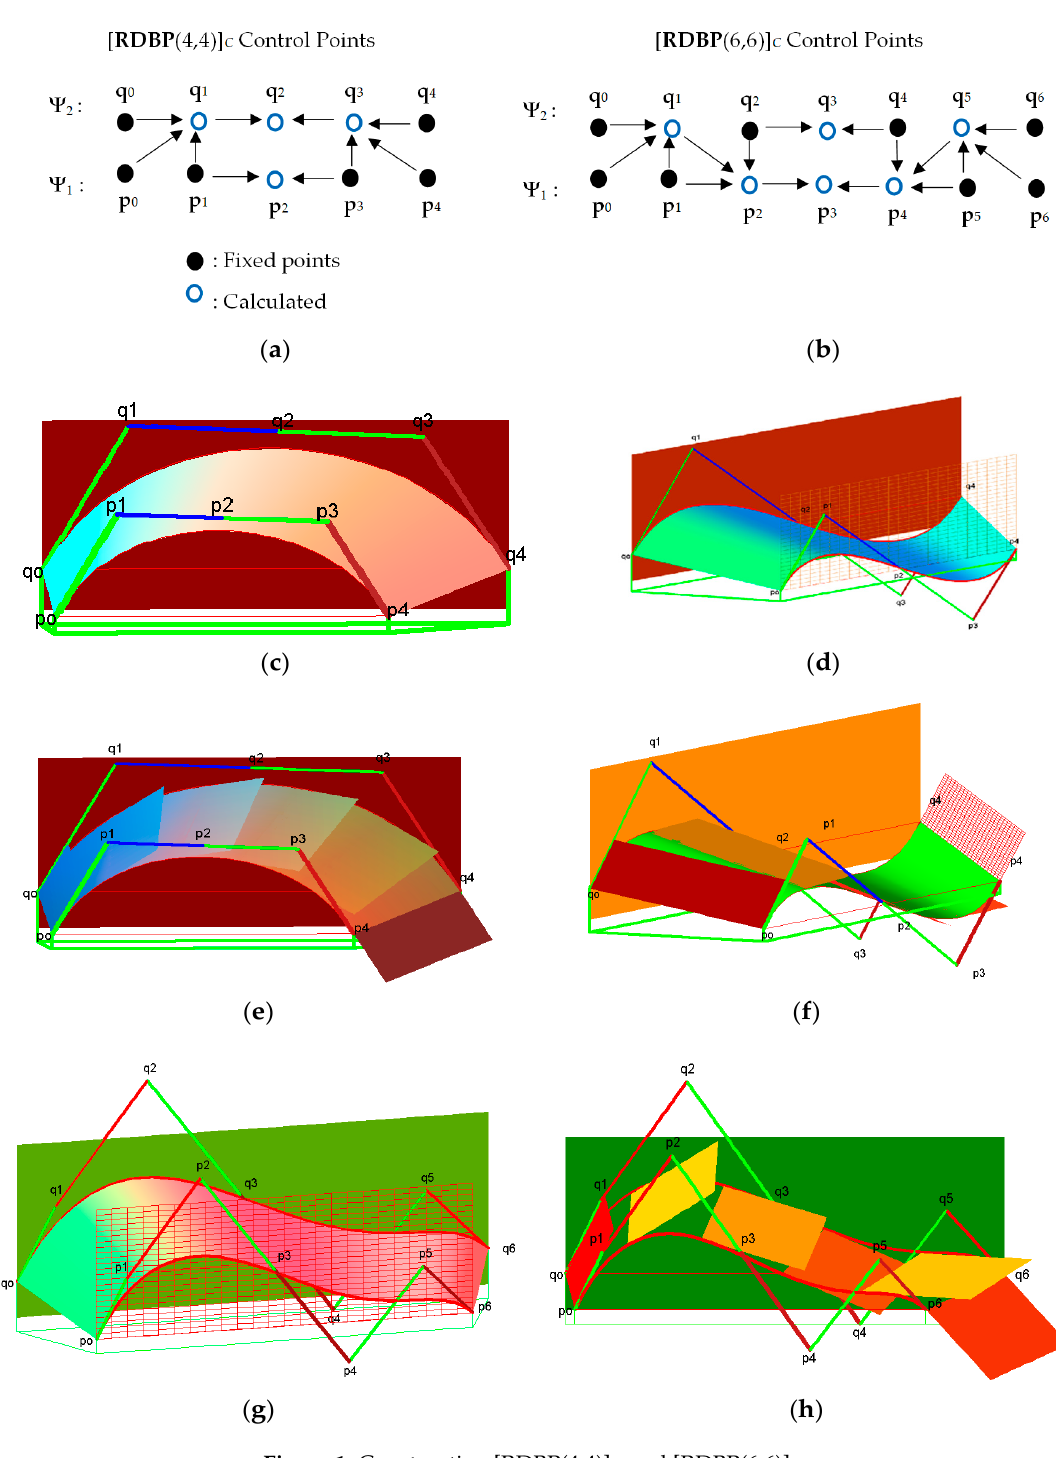
Figure 1. Construction [RDBP(4,4)] C and [RDBP(6,6)] C .